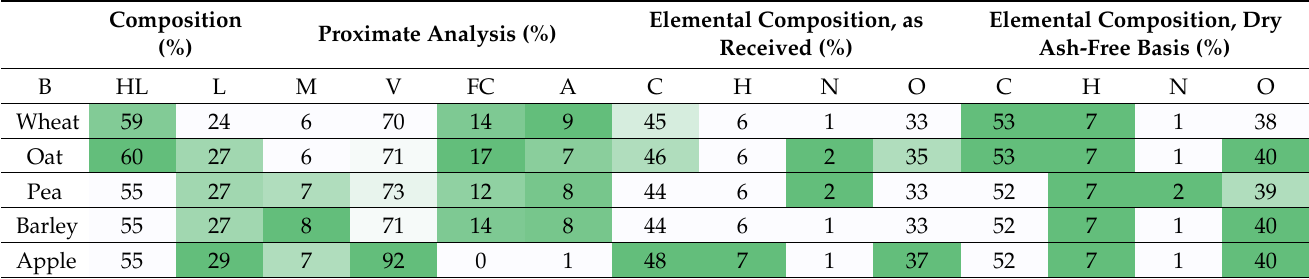
Table 2. Biomass feedstock composition and proximate analysis, with colour